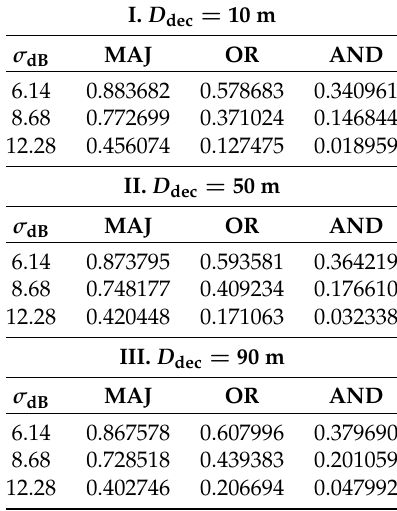
Table 1. AUCs for the uncoded MAJ, OR, and AND decision fusion rules, for σ dB = 6.14, 8.68, and 12.28 dB, L = 50 m, and D dec = 10, 50, and 90